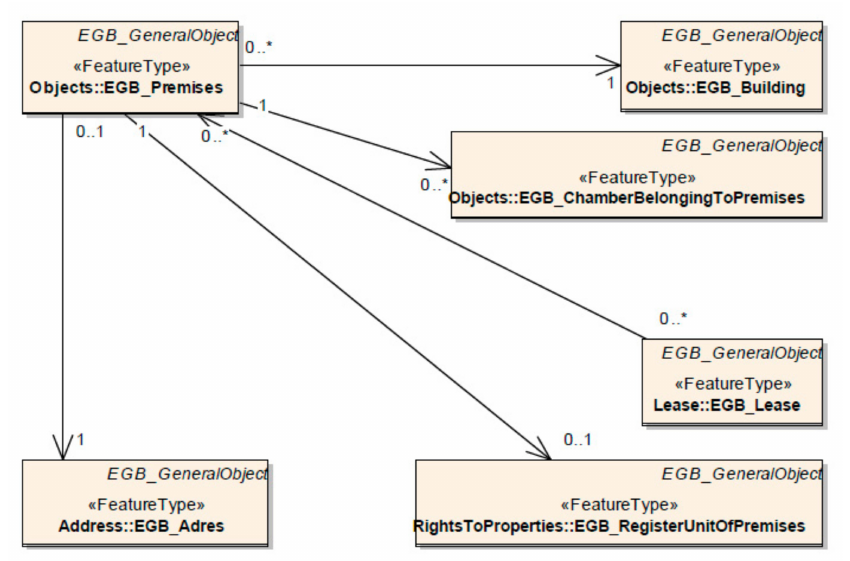
Figure 4. The relationships between ‘EGB_Premises’ and other classes of the Polish cadastral model.